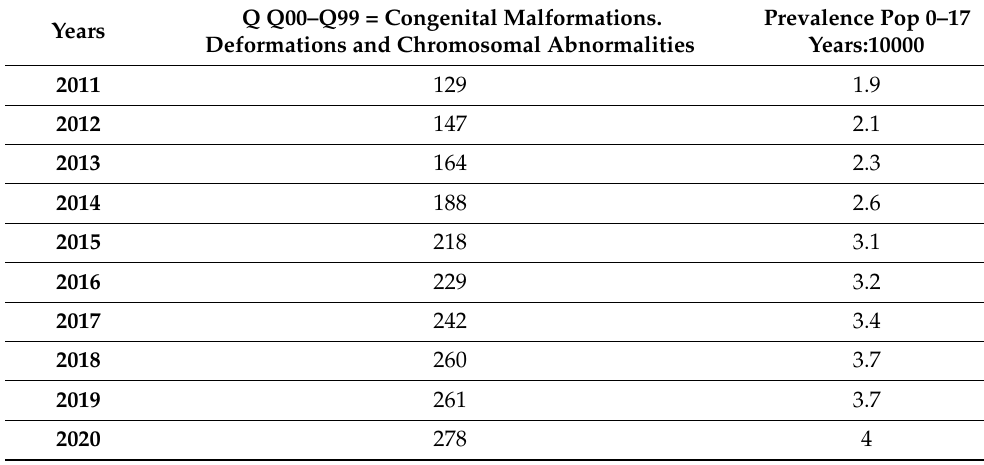
Table 6. Incidence of genetic malformations and genetic syndromes per